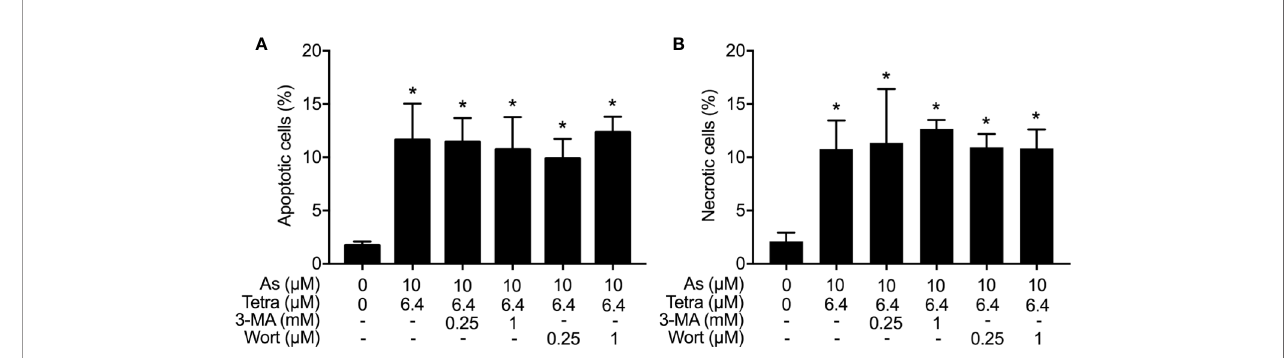
FIGURE 4 | Effects of autophagy inhibitors on the induction of apoptosis and necrosis in MDA-MB-231 cells treated with the combination of As III and Tetra. After treatment with 10 m M As III +6.4 m M Tetra in the presence or absence of 3-MA (0.25, 1.0 mM) or wortmannin (0.25, 1.0 m M) for 48 h, cells were stained with annexin V-FITC and PI, and analyzed by fl ow cytometry. The percentages of apoptotic cells (A) and necrotic cells (B) were quanti fi ed by the same manner as described in the legend of Figures 2 and 3 . *p<0.0001 vs. control. As, As III ; Tetra, tetrandrine; ( Figure 7C ). All of MAPK inhibitors and their respective negative control itself had no effect on the cell viability of MDA-MB-231 ( Figure 7 ).